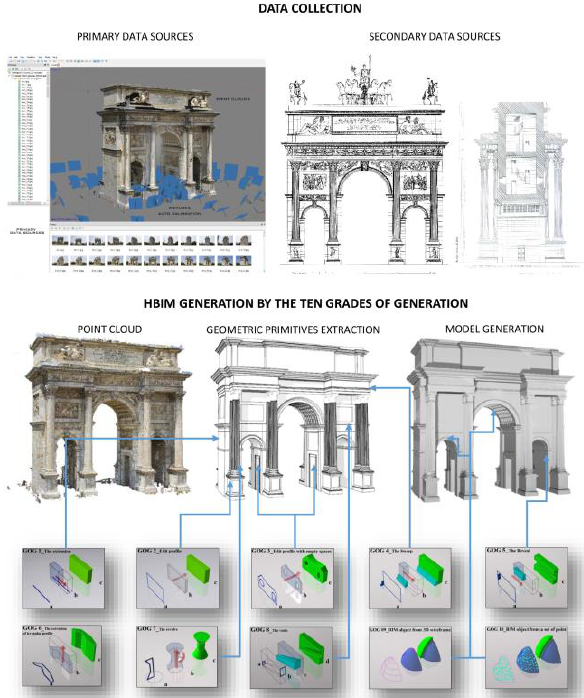
Figure 7. An accurate HBIM model and a proper 3D